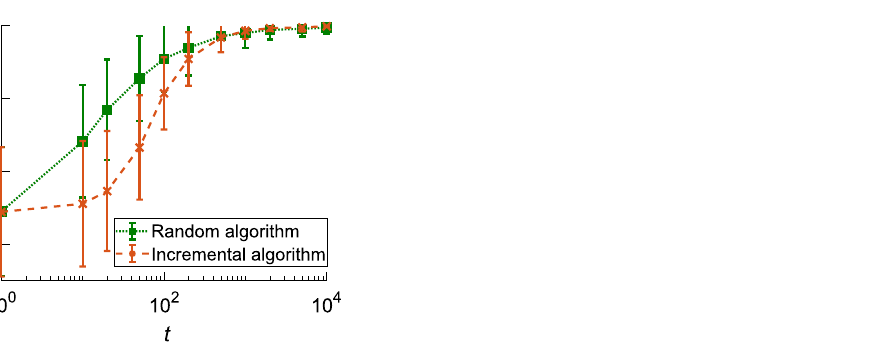
Figure 3. Modified Jain index I p during realignment when one player uses the proposed random algorithm (green line) or the previous incremental algorithm (orange line), for 100 identical random initial angles. Each result is the average of 20